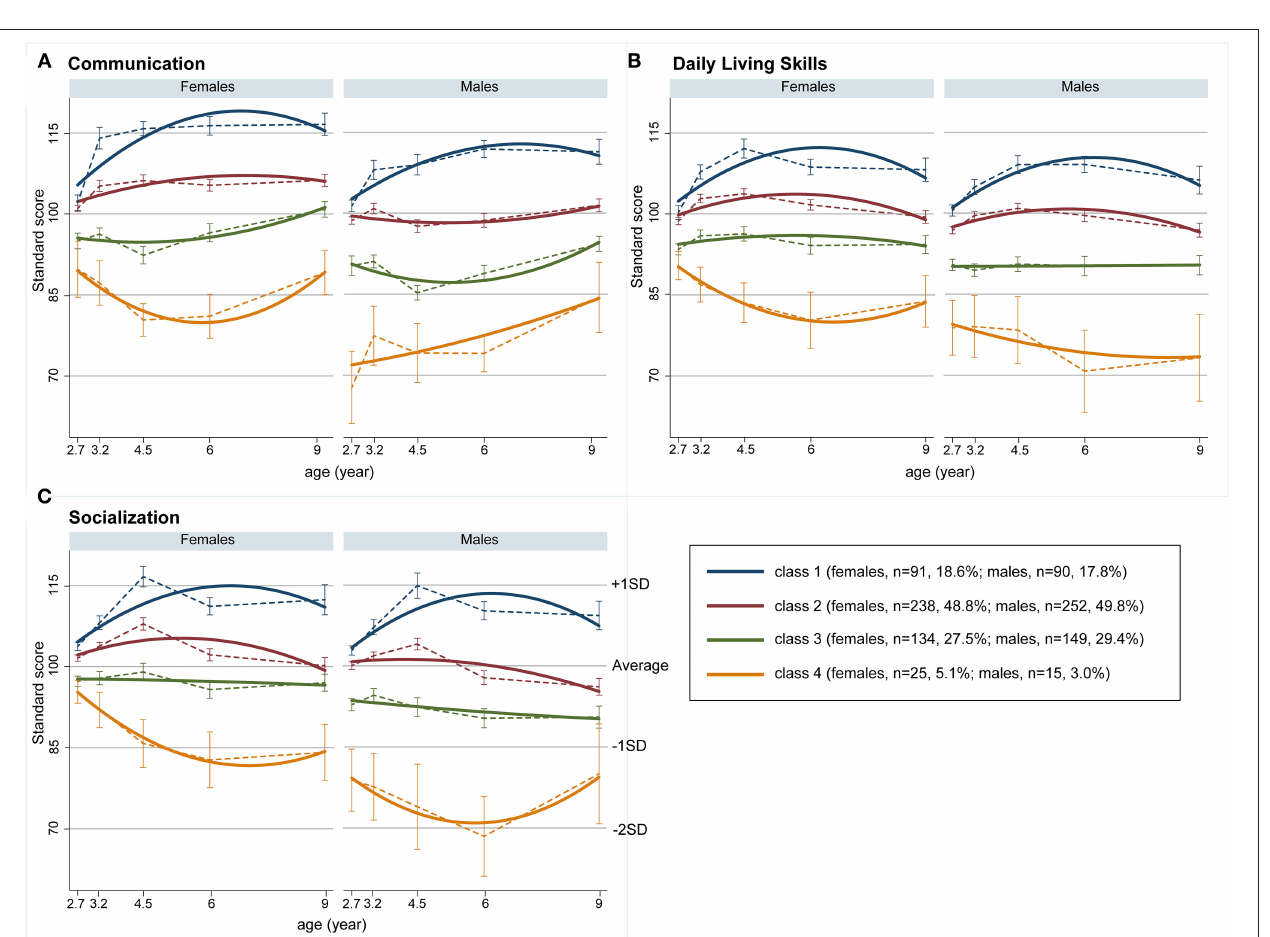
Frontiers in Psychiatry |